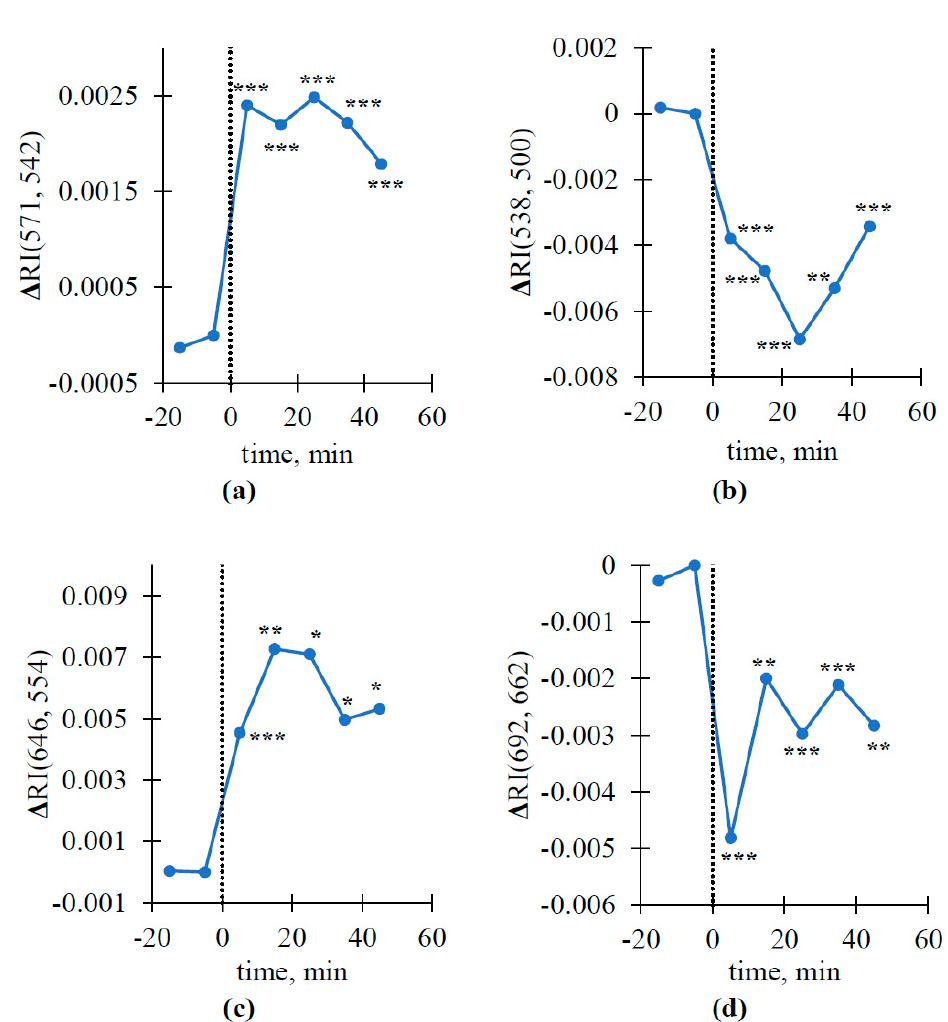
Figure 6. Dynamics of ∆ RI(571, 542) ( a ), ∆ RI(538, 500) ( b ), ∆ RI(646, 554) ( c ), and ∆ RI(692, 662) ( d ) before and after induction of variation potential in the second leaf ( n = 13). Burning of the first leaf was used for VP induction (the burning is marked by the time point zero and the dotted line). The Mann–Whitney U test was used for p -value calculations; parameters were compared to zero values (absence of changes). *, p < 0.05, **, p < 0.01, and ***, p < 0.001.